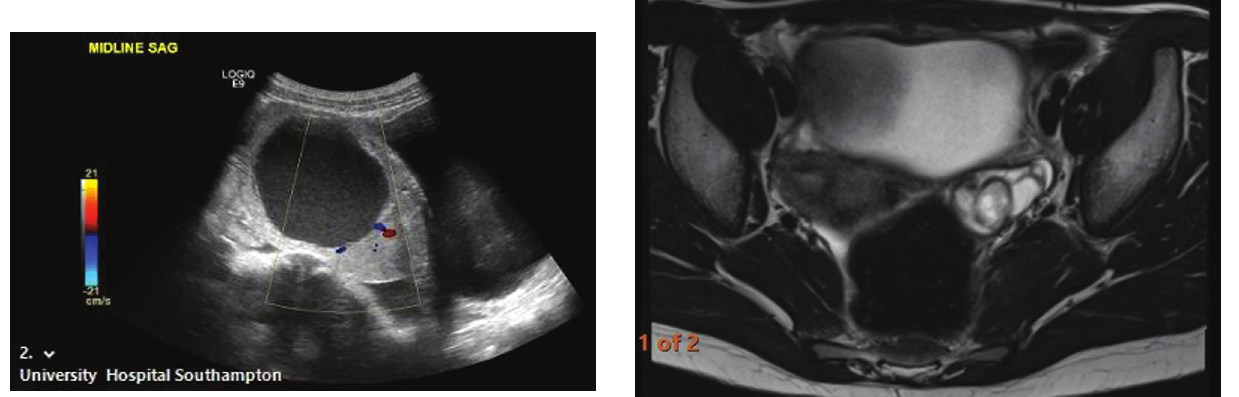
Fig. 1 Ultrasonography demonstrating a sagittal view of suspected left adnexal mass. Laparoscopy con fi rmed that the tumor was in fact associated with the right ovary.